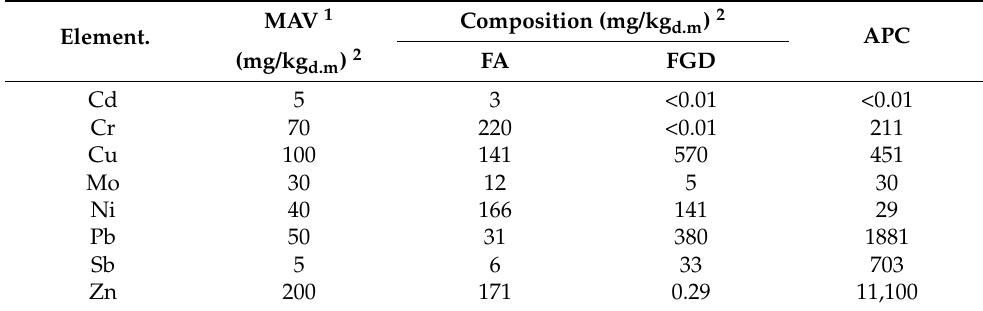
Table 1. Pollutant species concentrations in investigated residues [9]. Element.